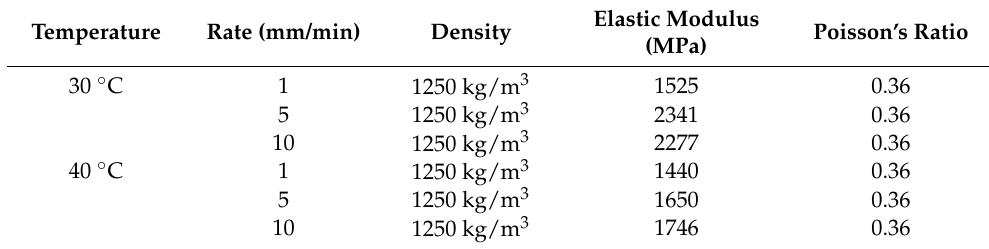
Table 1. Experimental parameters of FFF 3D-printed PLA tensile specimens.